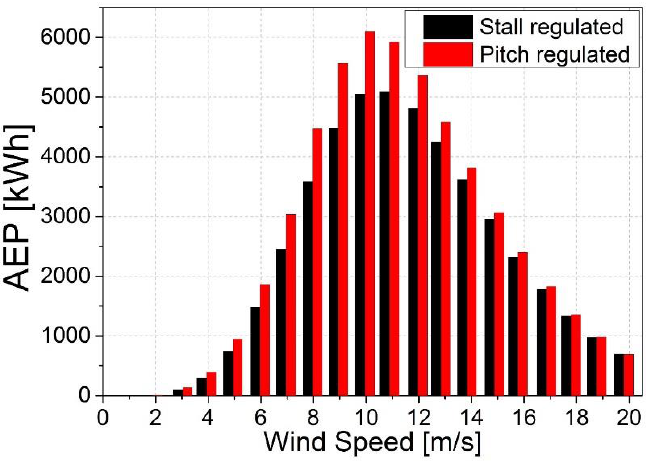
Figure 14. Annual energy production per wind average wind speed in dynamic conditions.